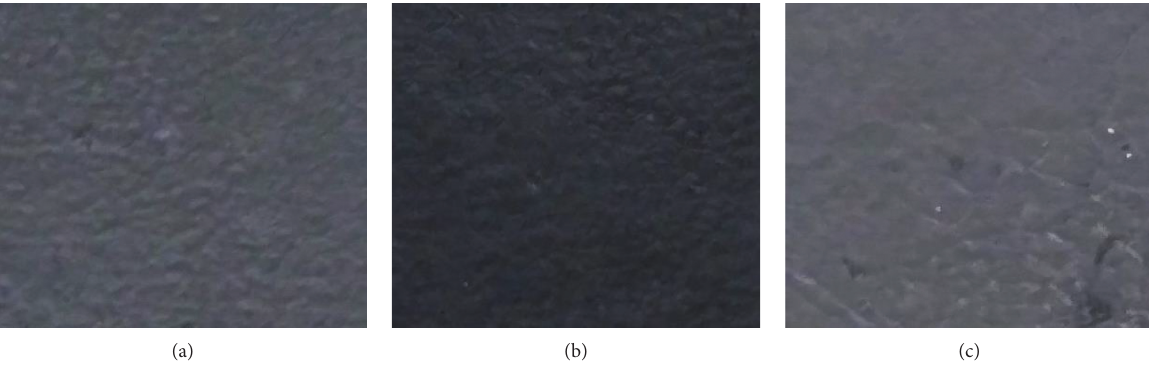
Figure 11: Photographs of the surface of the electrode-coated CI-EtOH (1/1) (a), CI-EtOH (1/0.5) (b), and CI-EtOH (1/2) inks.